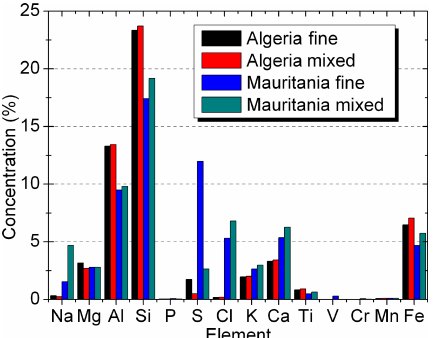
Figure 11. Mean mass concentration in percentage of the total mass of the aerosol particles obtained for each element for fine and mixed mode (fine + coarse) of the Saharan dust from Algeria and Mauri- tania by energy dispersive X-ray fluorescence analysis